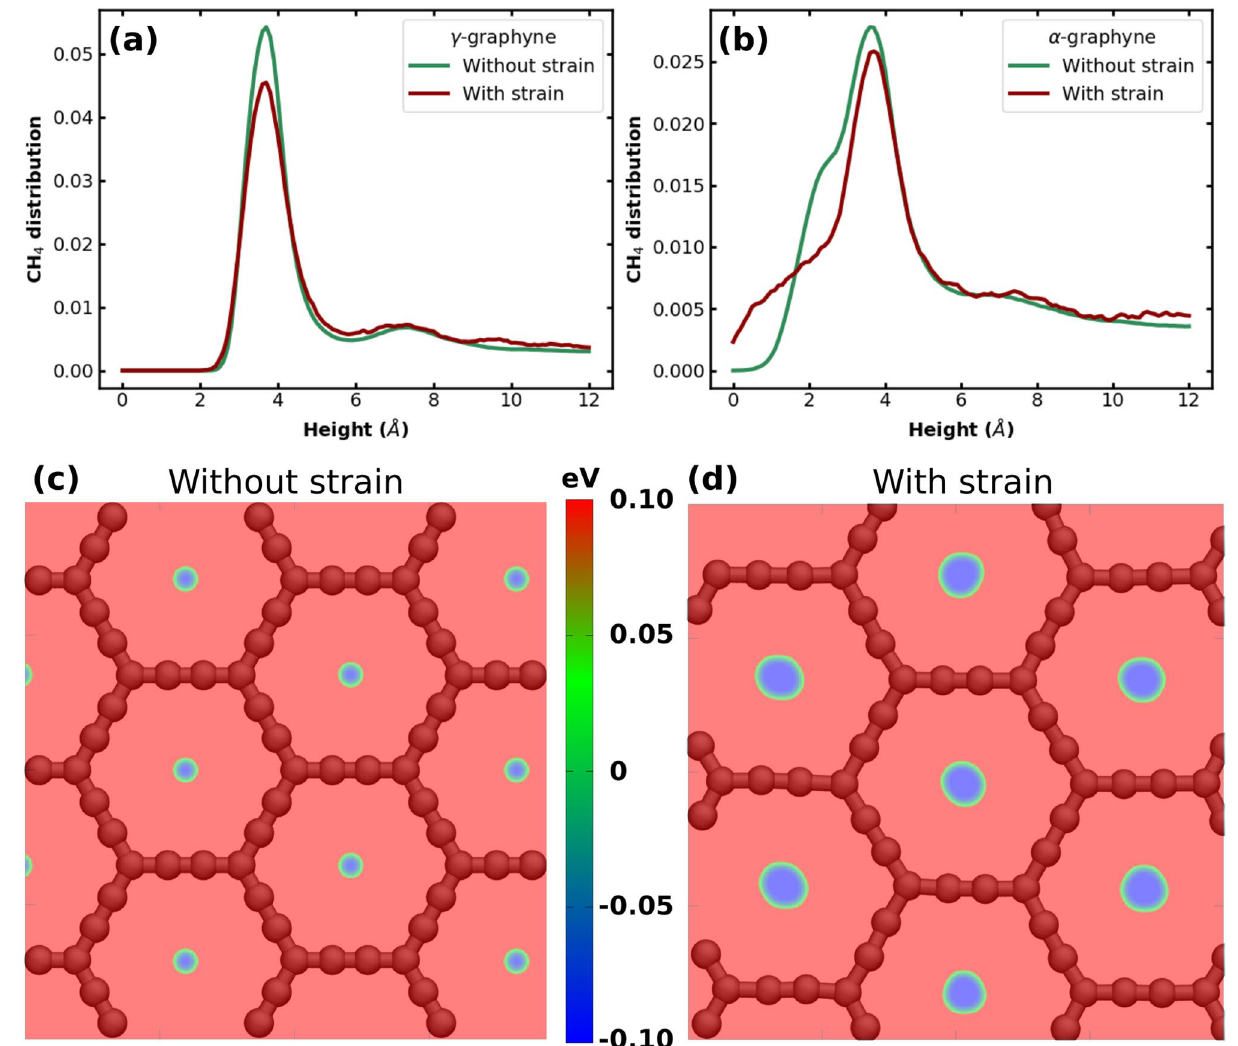
Figure 6. Histogram detailing the distribution of CH 4 molecules over γ -graphyne ( a ) and α -graphyne ( b ). Potential energy map for CH 4 above α -graphyne without ( c ) and with strain ( d ). The molecule is at a fixed height above the surface ( h = 0.5